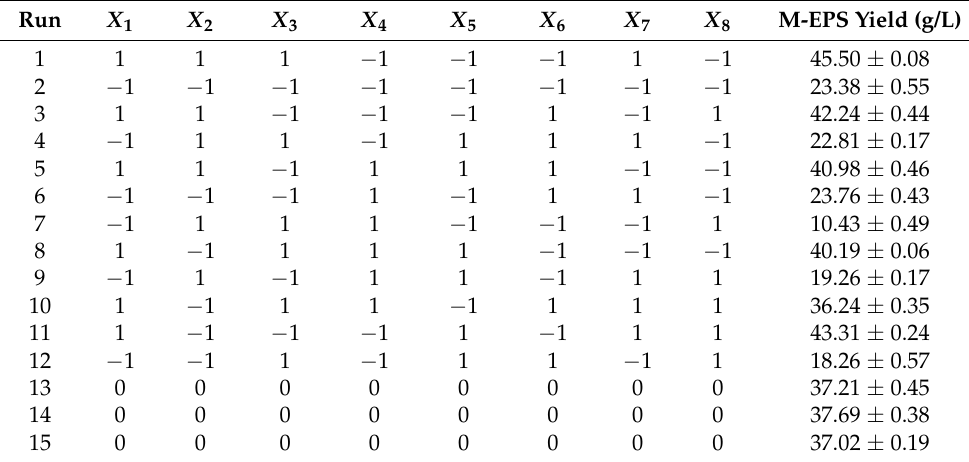
Table 1. Experimental design and results of the Plackett-Burman design.